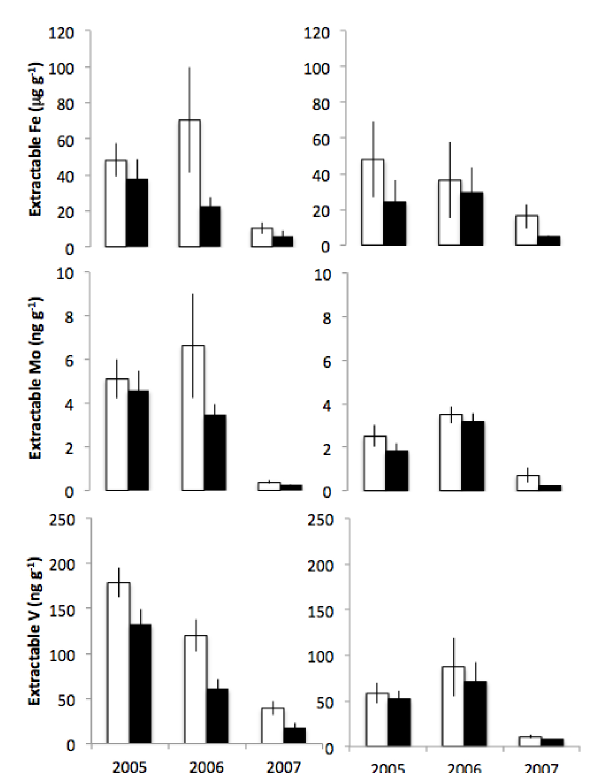
Figure 3. Soil-extractable Fe, Mo, and V concentrations for 0– 10cm (left three panels) and 10–30cm (right three panels) soil depths over the last three years of the experiment. Values are means ± standard error of the mean. Units areµgg − 1 soil (for Fe) and ngg − 1 soil (for Mo and